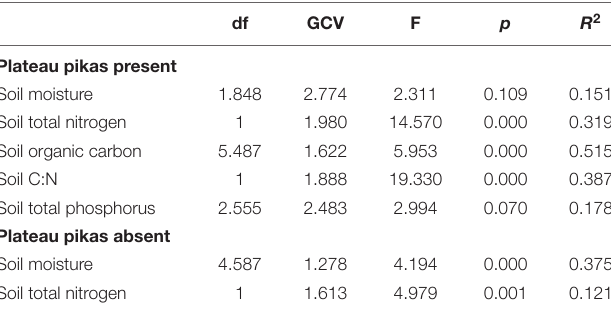
TABLE 1 | Generalized additive models of the relationships of BGB/AGB with plant community biomass and soil properties in the presence and absence of plateau